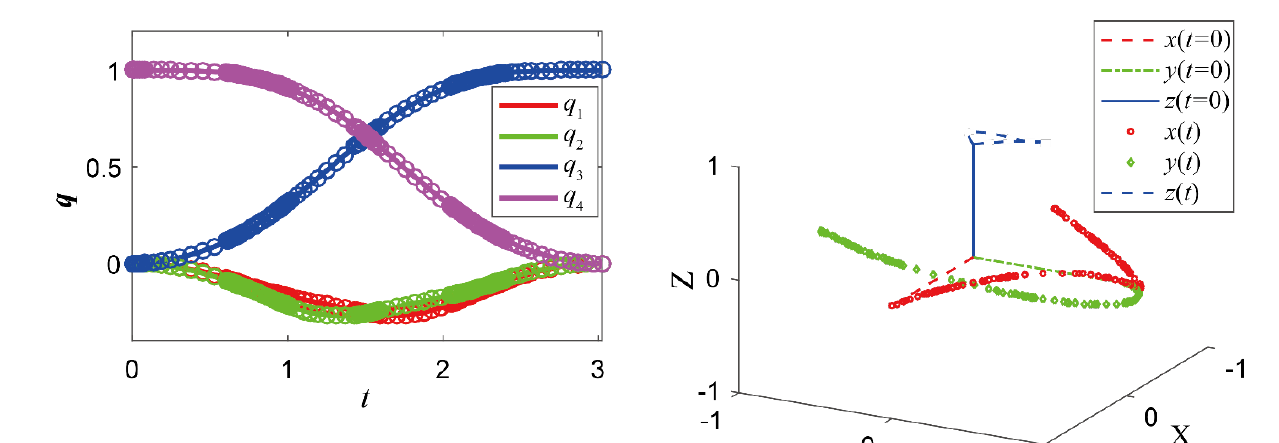
Figure 5. Quaternion histories and the validation by propagation for Case 1.